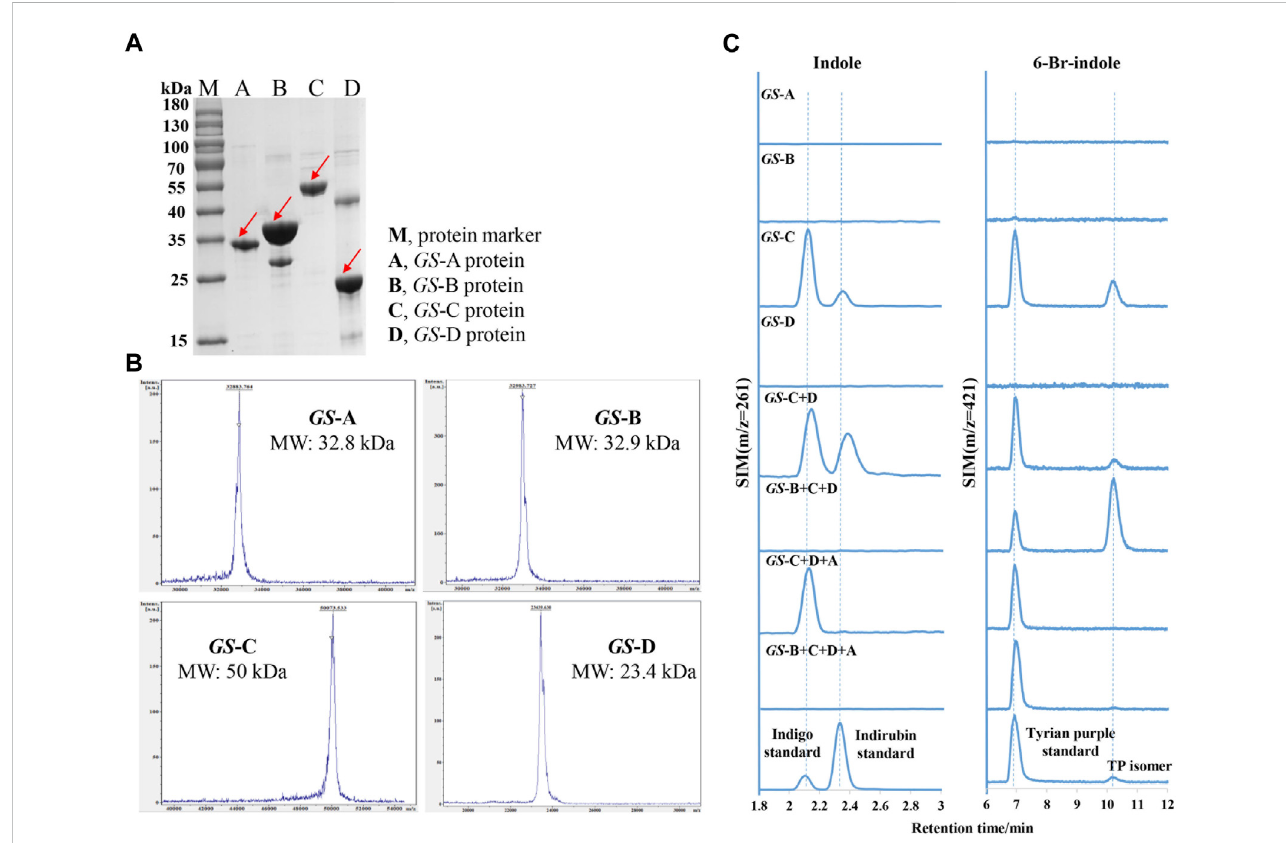
FIGURE 4 Puri fi cationandcharacterization ofindolebiodegradationgenecluster. (A) SDS-PAGEanalysisofthepuri fi edfour GS proteins.M,proteinmarker;A, GS - A; B, GS -B; C, GS -C; D, GS -D. (B) MALDI-TOF mass spectrometry of the puri fi ed four GS proteins. (C) Extracted ion chromatograms for the standards (the lower) of indigo (m/z = 261), indirubin (m/z = 261), Tyrian purple (m/z = 421), and production of in vitro reactions by different GS proteins supplemented with indole or 6-bromo-indole,